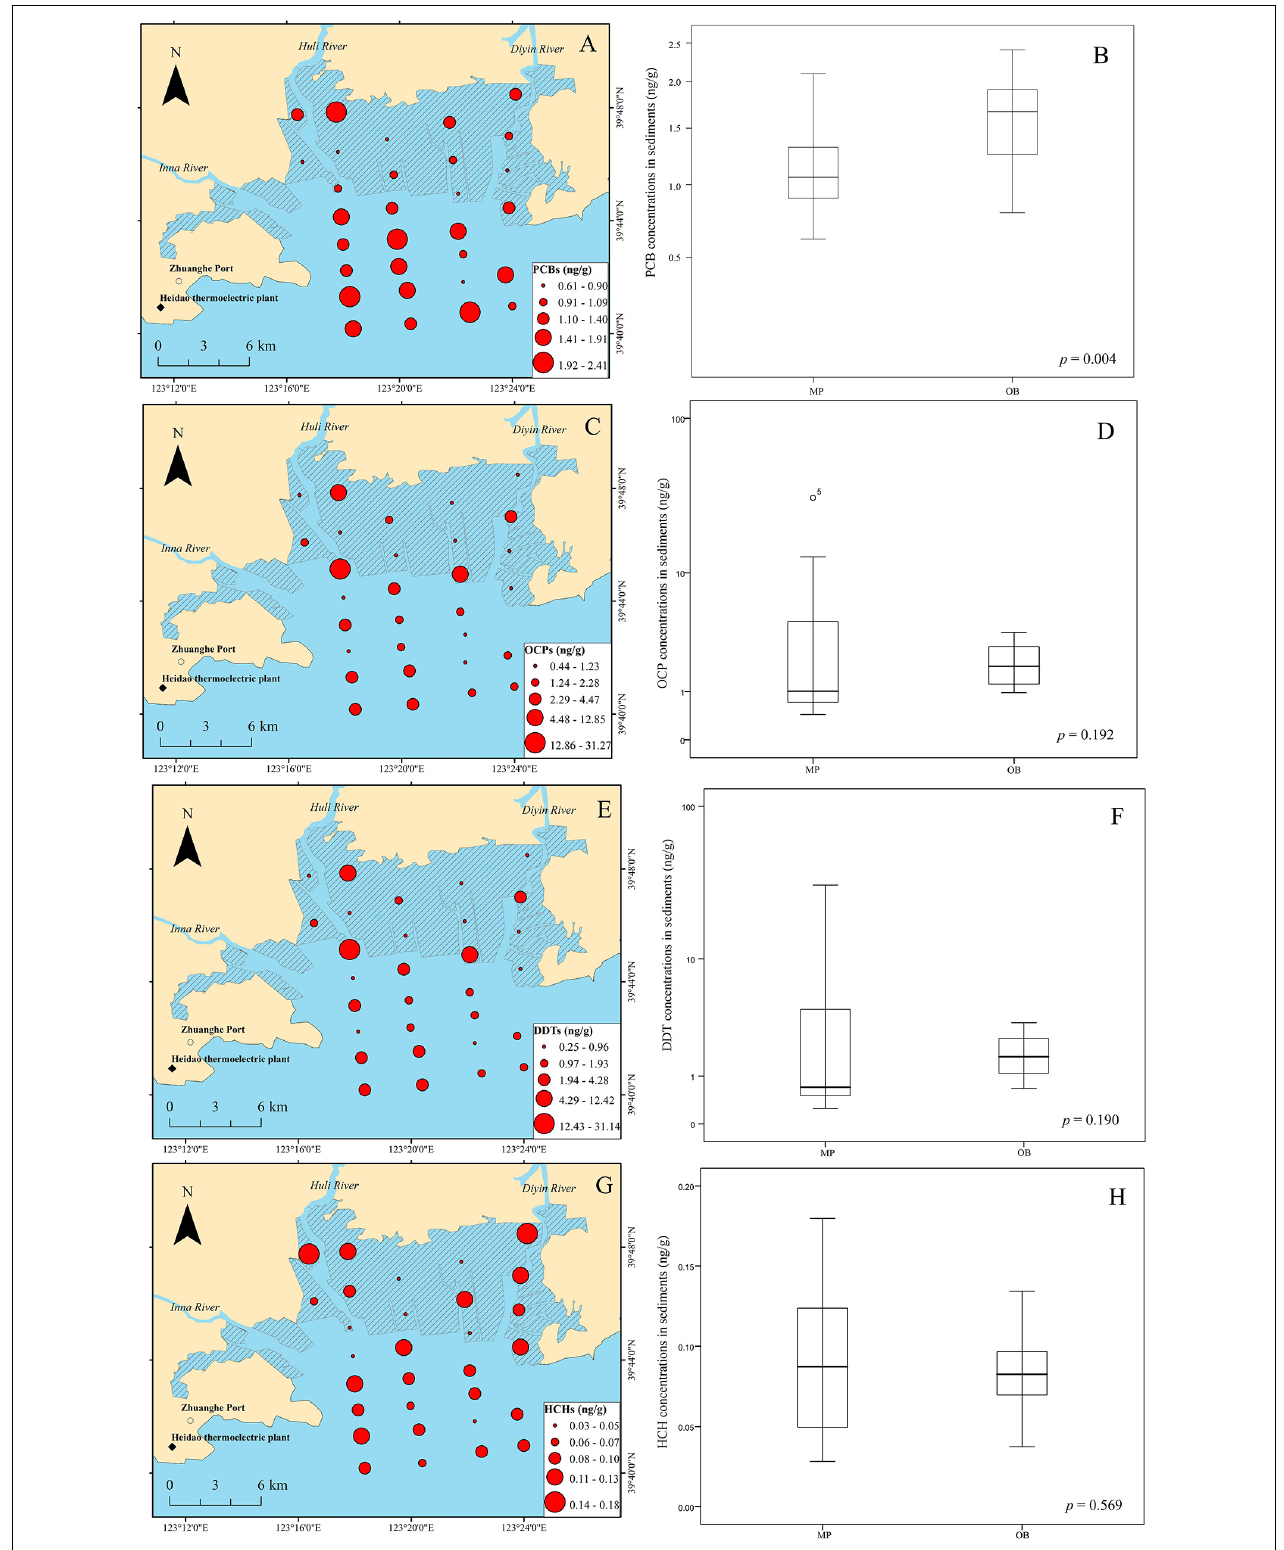
FIGURE 3 | Spatial distribution of PCBs (A) , OCPs (C) , DDTs (E) and HCHs (G) , and boxplots for PCBs (B) , OCPs (D) , DDTs (F) and HCHs (H) in the surface sediments of Qingduizi Bay.